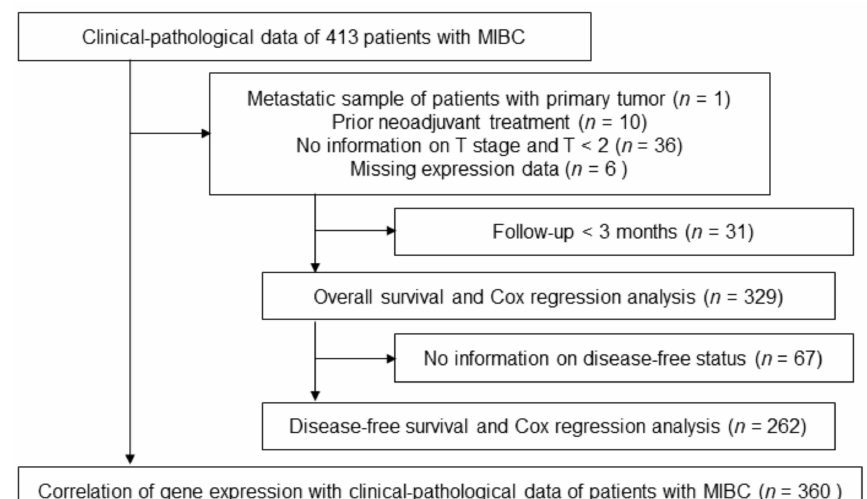
Figure 2. Inclusion and exclusion scheme of The Cancer Genome Atlas (TCGA) cohort. Abbreviations: MIBC, muscle-invasive bladder cancer.